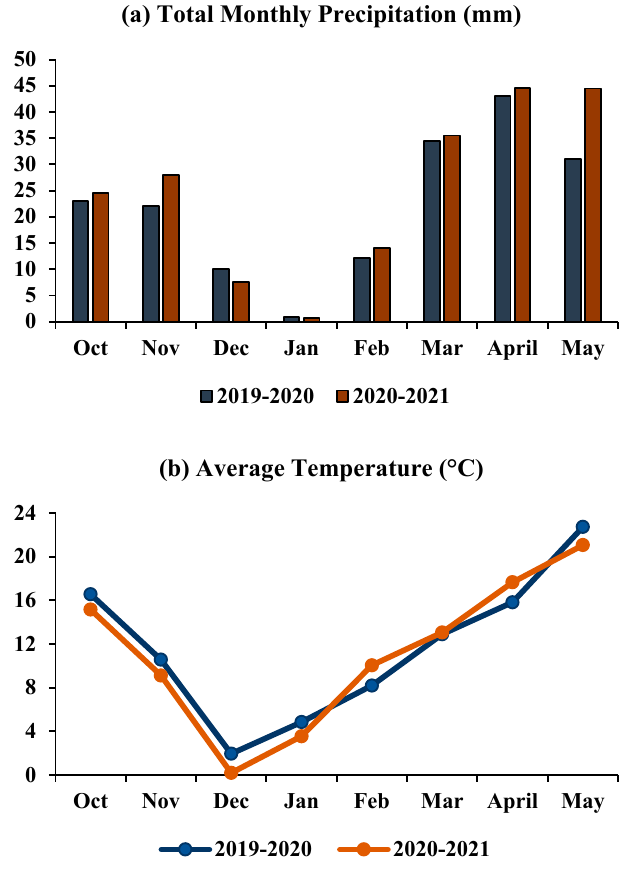
Figure 1. Meteorological data recorded during the 2019–2020 and 2020–2021 growing seasons; ( a ) total monthly precipitation, ( b ) monthly average temperature.